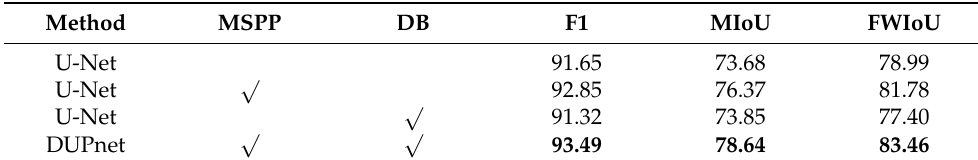
Table 4. Quantitative comparison of ablation study in terms of F1, MIoU, and FWIoU (%) on the 2020 Gaofen challenge water body segmentation dataset. Symbol ( to be used in the original U-Net.